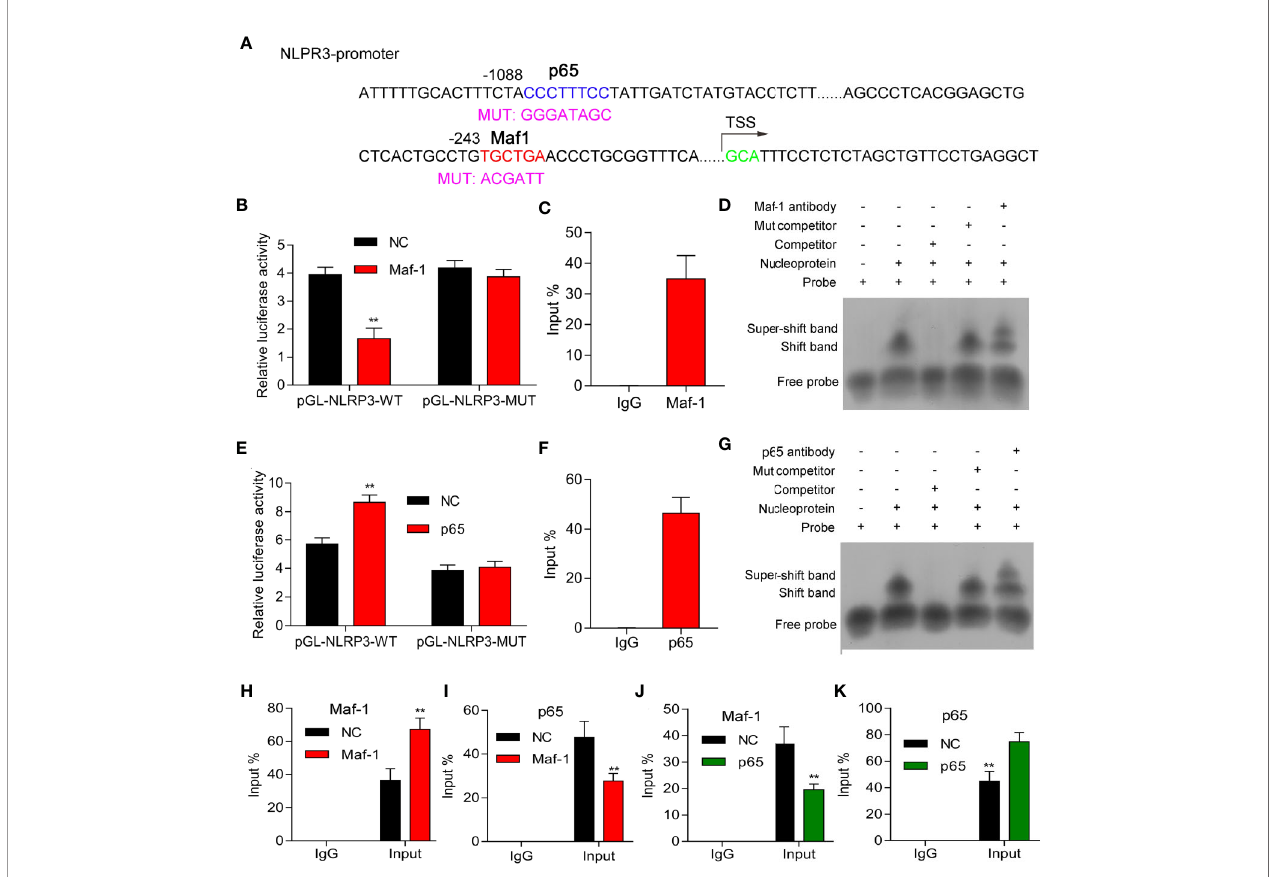
FIGURE 4 | Maf1 and p65 directly bound to the NLRP3 promoter. (A) The mutant binding site of the NLPR3 promoter. (B, E) HEK293T cells were co-transfected with pcDNA4.0 or pcDNA4.0-Maf1/pcDNA4.0-p65 vectors and pGL-NLRP3-WT orpGL-NLRP3-MUT vectors, and the relative luciferase activities are shown. (C, F) ChIP assays were performed to determine the binding of Maf1 and p65 to the NLRP3 promoter in BMECs in vitro . (D, G) EMSA assays were performed to detect the direct binding of Maf1 and p65 to the NLRP3 promoter in BMECs in vitro . (H – K) ChIP assays were performed to explore howMaf-1 or p65 regulated the NLRP3 promoter in BMECs. Total chromatin from cell culture as the input, and normal rabbit IgG served as the negative control antibody. Results are expressed as the mean value ± SD of data obtained from three separate experiments, ** p < 0.01, compared with